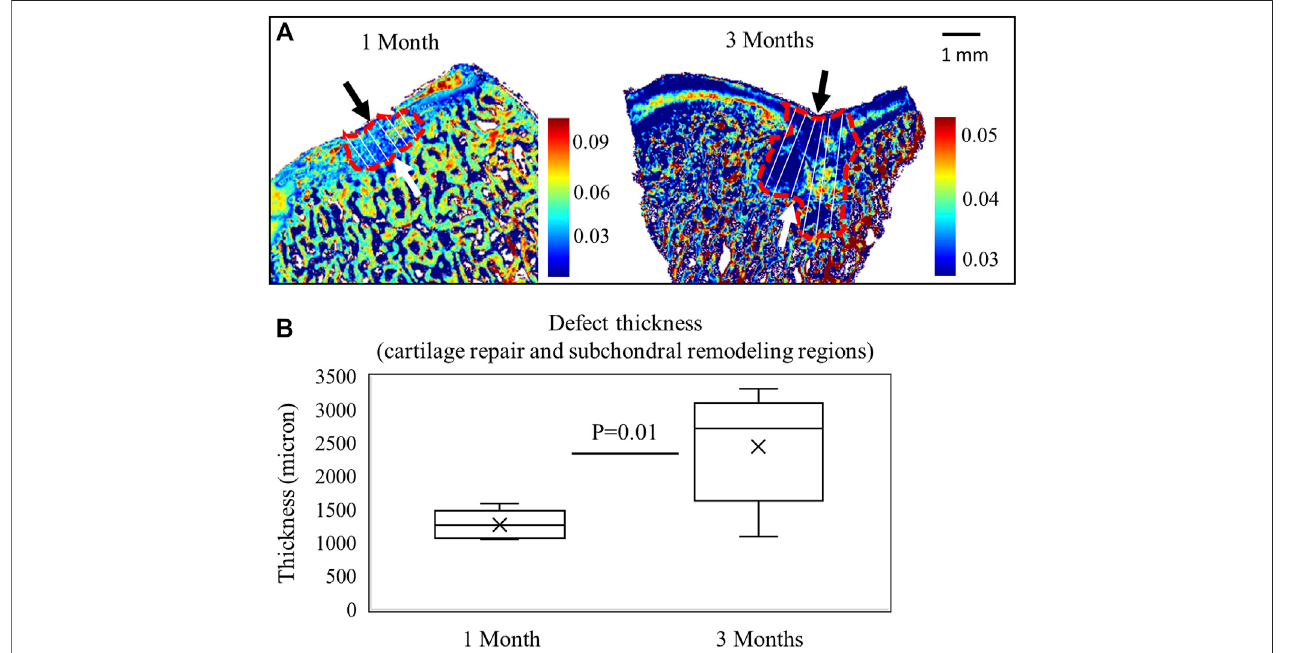
FIGURE5|(A) FTIRimagesbasedonthe1338 cm − 1/ AmideIIareasafter1 monthofrepairinamatureanimal( n =9)and3 monthsofrepairinajuvenileanimal( n = 6).Themeasurementlinesofdefectthicknessareshown,includingbothcartilagerepairandsubchondralremodelingregions. (B) Defectthicknessissigni fi cantlygreater in the 3-month animals (Student ’ s t -test).